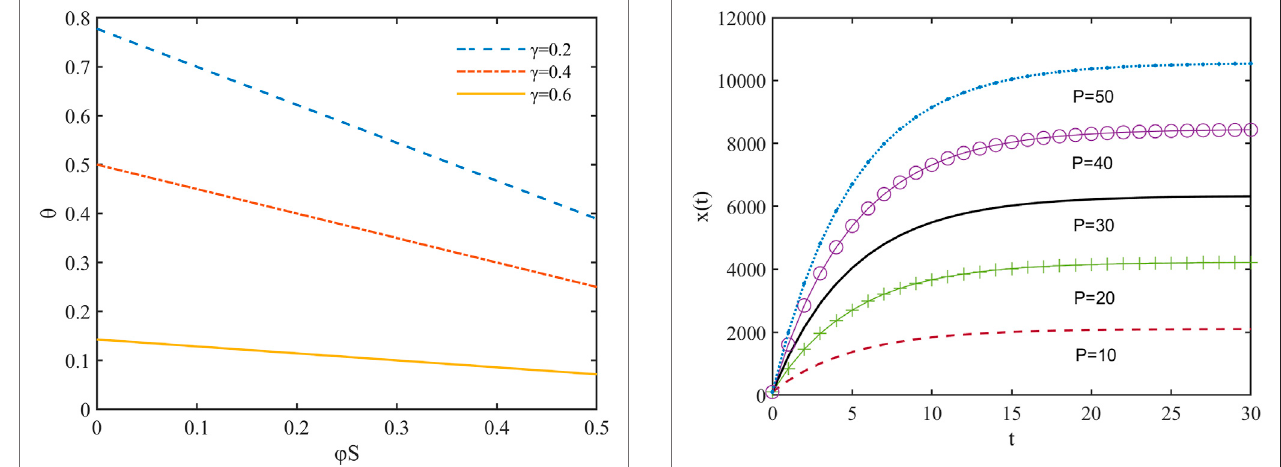
FIGURE 4 | The impact of γ and φ S on θ .